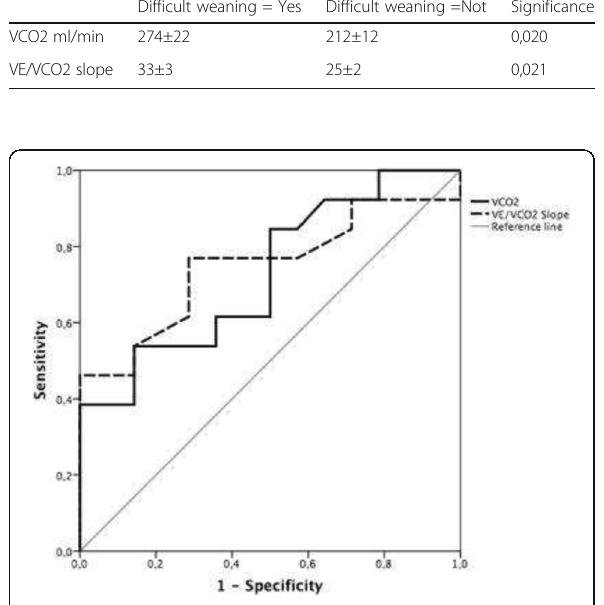
Fig. 1 (abstract 0150). ROC curves between physiological variables from VC and difficult weaning